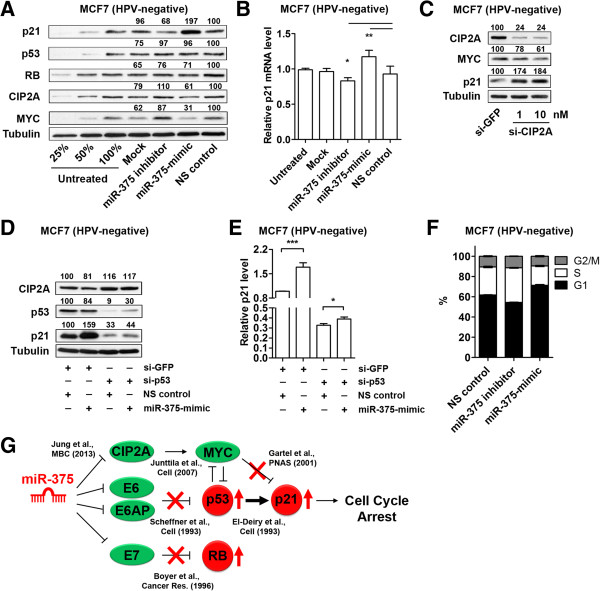
miR-375 control on CIP2A-MYC pathway also contributes to p21 elevation. (A) p21, p53, RB, CIP2A, and MYC protein levels in MCF7 cells transfected with miR-375 inhibitor, -mimic, or NS control were measured by Western blot analysis. Tubulin expression was used as internal control. 25%, 50%, 100% amounts of untreated cell lysates were included to calibrate the semiquantitative measurement. (B) Transfection with miR-375-mimic significantly upregulated p21 mRNA in MCF7. Relative endogenous p21 mRNA levels were measured in MCF7 cells transfected with miR-375 inhibitor, -mimic, or NS control for 48 h using qRT-PCR. (C) CIP2A and MYC protein levels were effectively silenced by si-CIP2A transfection with 1 and 10 nM concentrations for 48 h. Increased p21 protein levels were detected in si-CIP2A dose-dependent manner. 10 nM of si-GFP was used as a control. (D) Protein levels of CIP2A, p53, and p21 in MCF7 cells transfected with si-p53 and/or miR-375-mimic were measured by Western blot analysis. (E) mRNA levels of p21 in MCF7 cells transfected with si-p53 and/or miR-375-mimic were measured by qRT-PCR. (F) Flow cytometry analysis demonstrates G1 arrest of MCF7 cells 48 h after transfection with miR-375-mimic compared to miR-375 inhibitor or NS control. The concentrations of siRNA or miRNA used in panels D, E, and F were 10 nM and 25 nM, respectively. (G) Schematic depiction of miR-375-mediated repression of CIP2A, E6, E6AP, and E7 in HPV16-positive cells that simultaneously increases tumor suppressor p53, p21, and RB, and causes cell cycle arrest. Results are expressed as mean ± SD from three independent experiments. *p < 0.05, **p < 0.01, and ***p < 0.001.